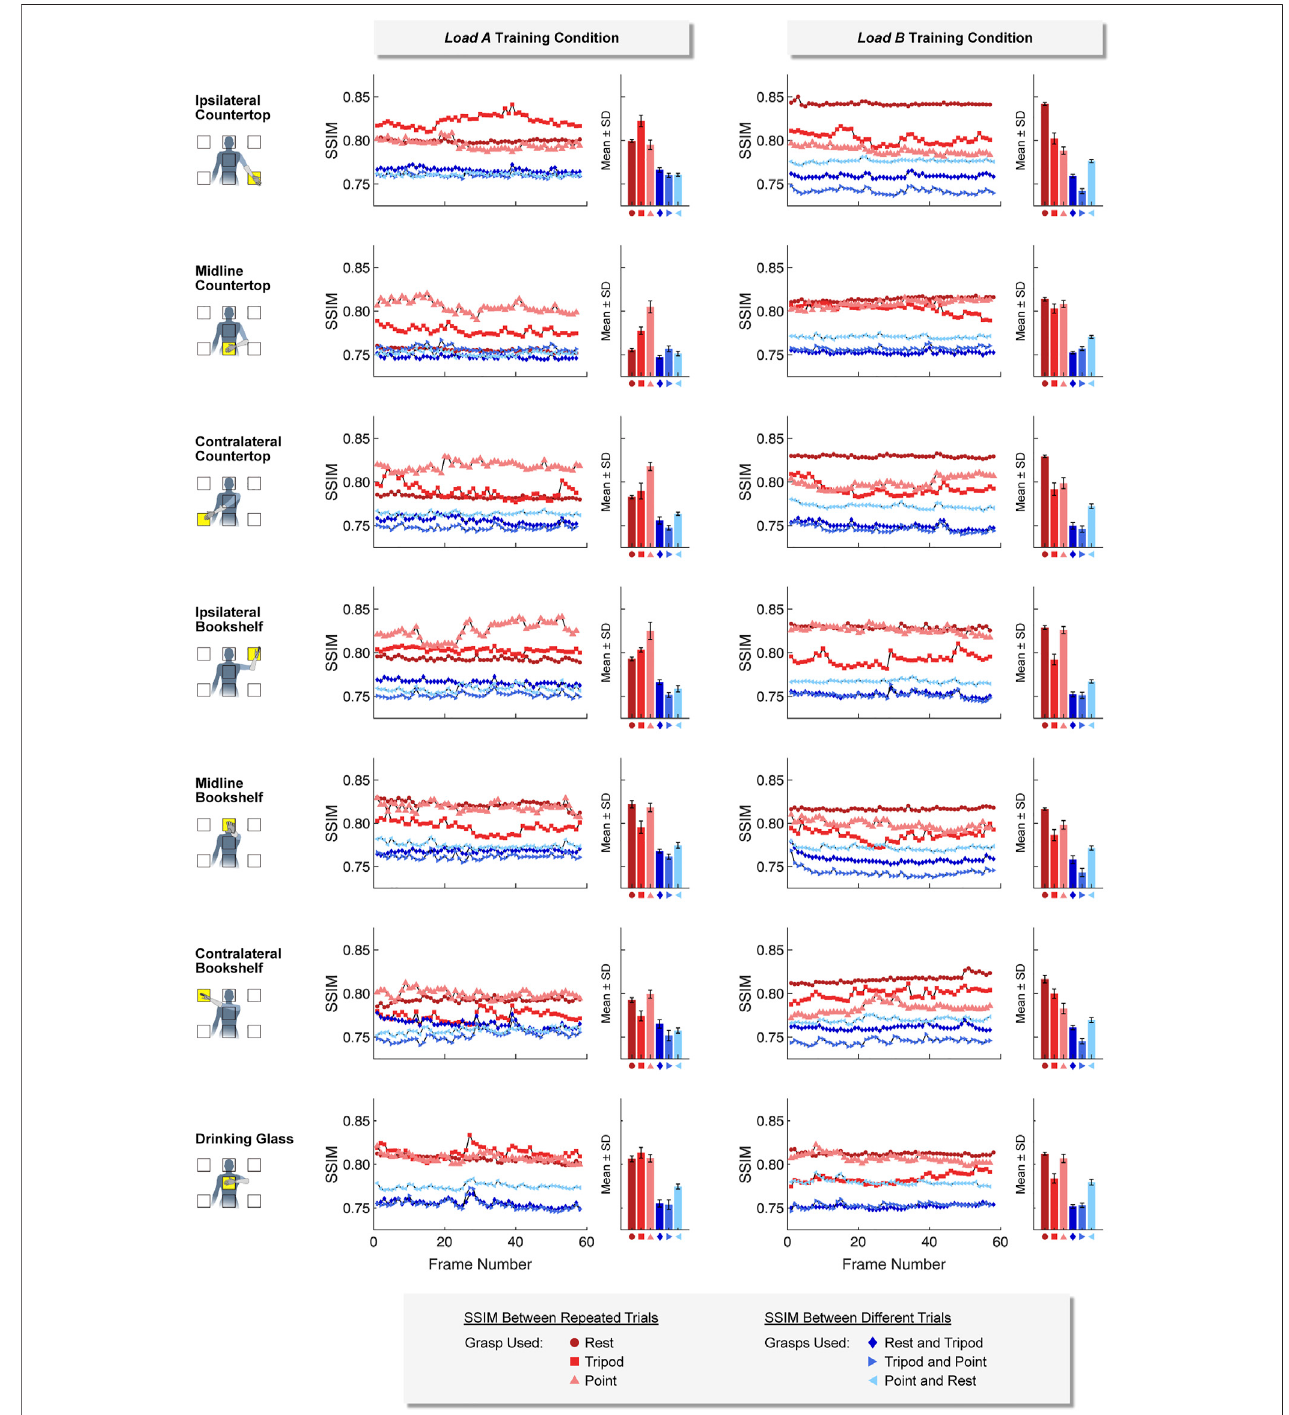
FIGURE 7 | For the static training strategy, we found that ultrasound images collected using the same hand grasp (i.e., repeated trials) were more similar to each otherthan ultrasound images collected using differenthand grasps (i.e., different trials). TheStructuralSimilarity Index (SSIM) wascalculatedfor each image frame ofthe respective 5-sec training